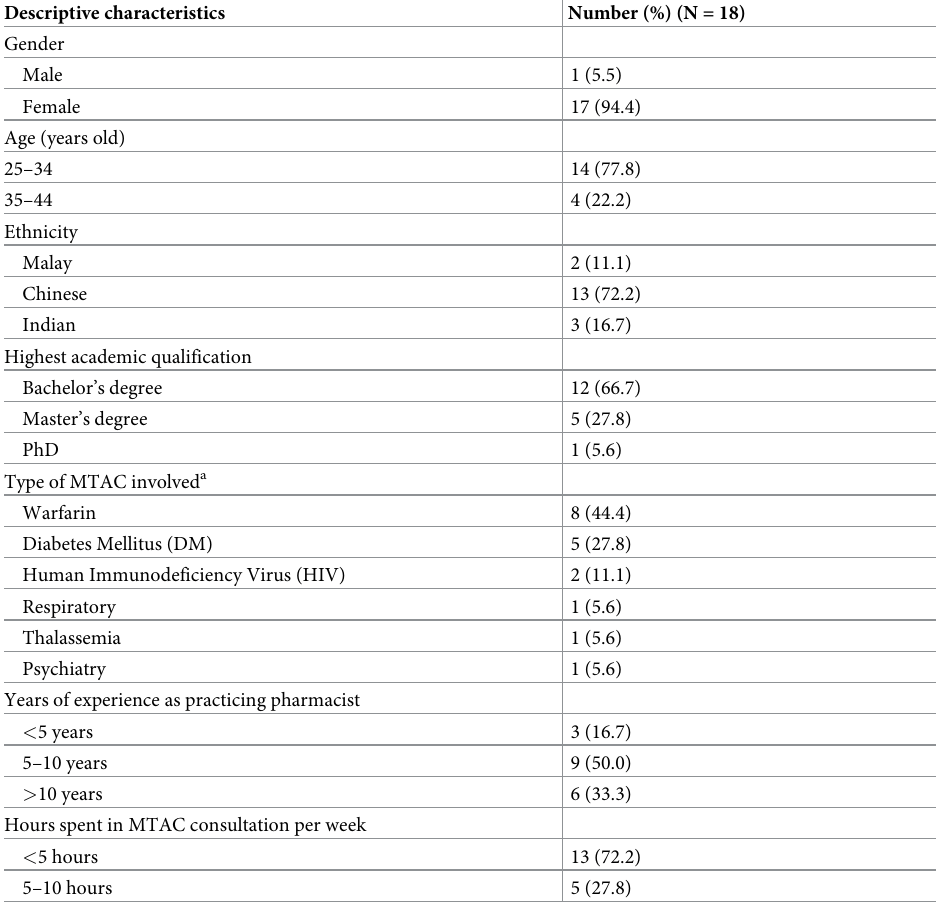
Table 2. Demographic characteristics of